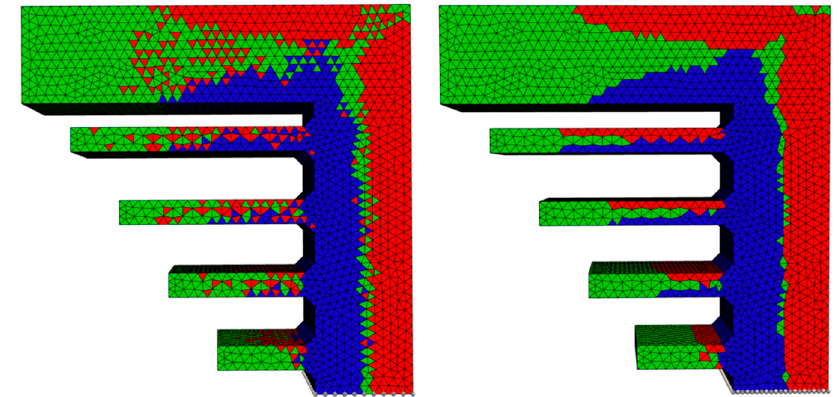
Figure 10. Comparison of linear ( left ) and quadratic ( right ) meshed staircase.